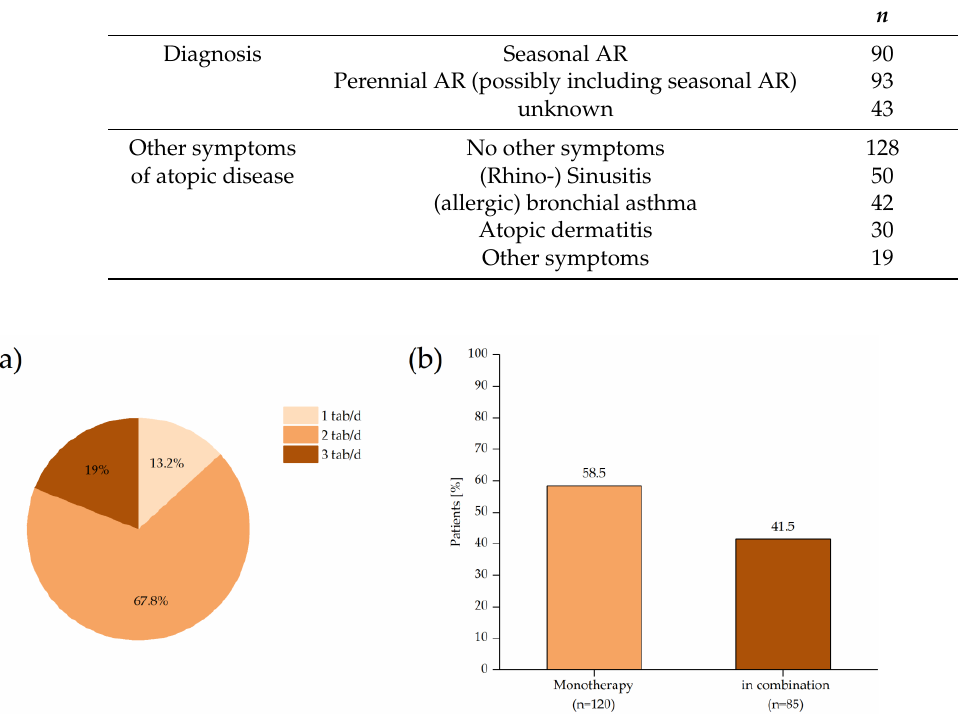
Figure 3. Treatments of patients: ( a ) Treatment regime from the baseline visit (Visit 1). From